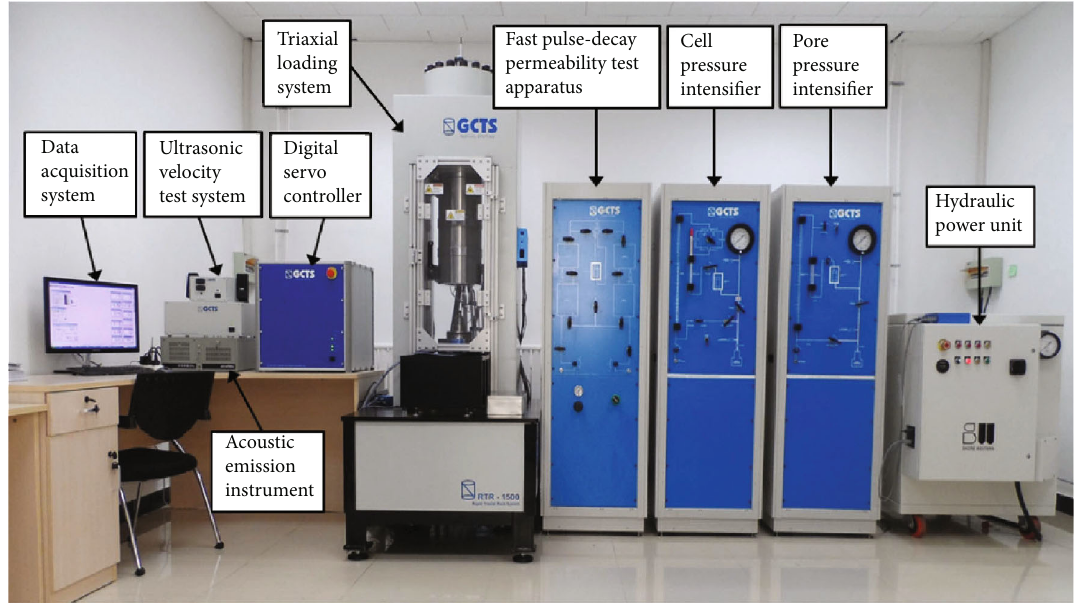
Figure 11: High-pressure and high-temperature triaxial test system integrated with pulse-decay permeability test